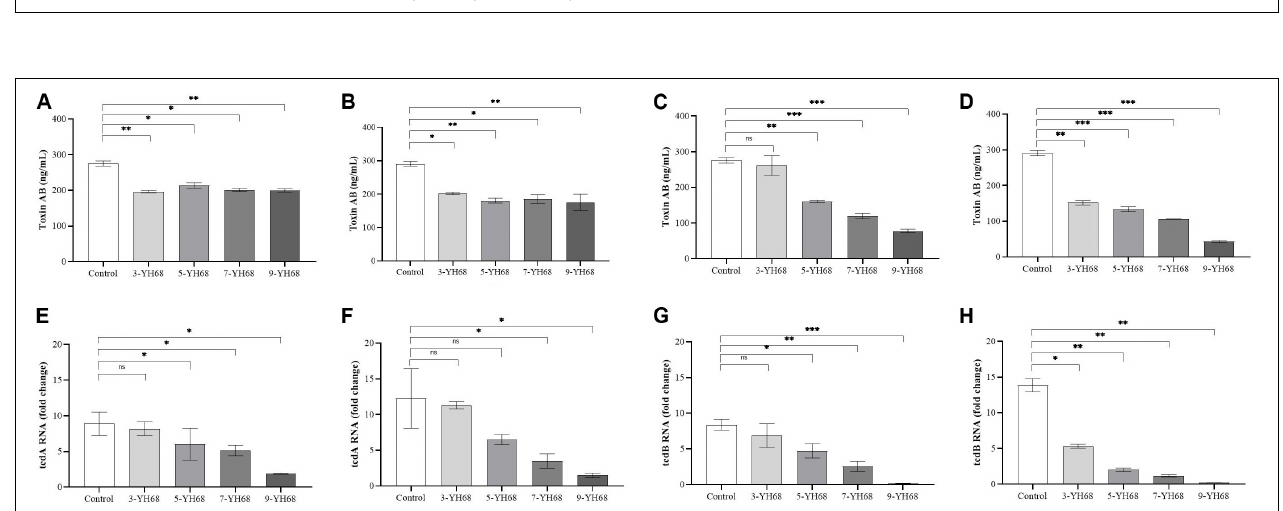
FIGURE 2 | Inhibitory effects of YH68 at different doses against toxin production and virulence gene expression of C. difficile . (A) Inhibitory effects of YH68-cell against toxin production at 24 h, (B) Inhibitory effects of YH68-cell against toxin production at 48 h, (C) Inhibitory effects of YH68-CFCS against toxin production at 24 h, (D) Inhibitory effects of YH68-CFCS against toxin production at 48 h, (E) Inhibitory effects of YH68-CFCS against tcdA gene expression at 24 h, (F) Inhibitory effects of YH68-CFCS against tcdA gene expression at 48 h, (G) Inhibitory effects of YH68-CFCS against tcdB gene expression at 24 h, and (H) Inhibitory effects of YH68-CFCS against tcdB gene expression at 48 h. (Sterile water is used as a control, ns, not significant, ∗ p < 0.05, ∗∗ P < 0.01, and ∗∗∗ P < 0.001; Dunnett’s multiple comparisons test).